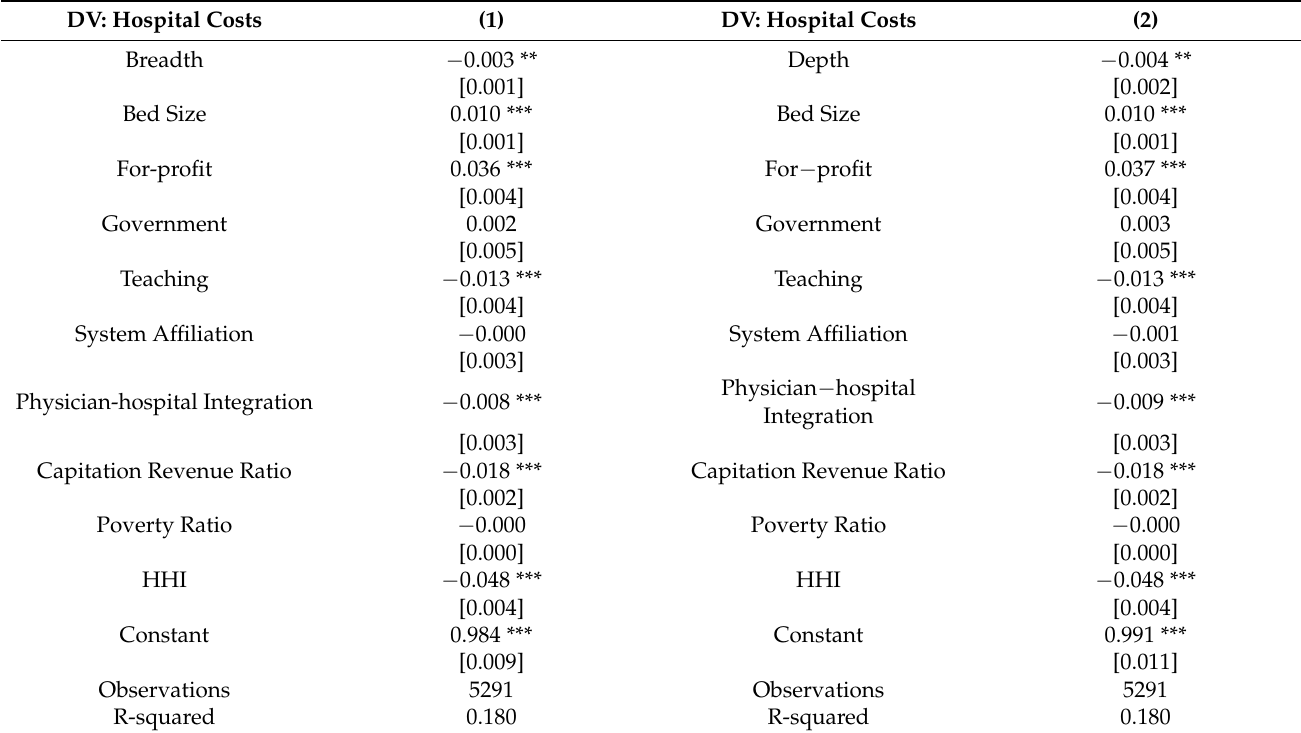
Table 2. The impact of health information sharing on